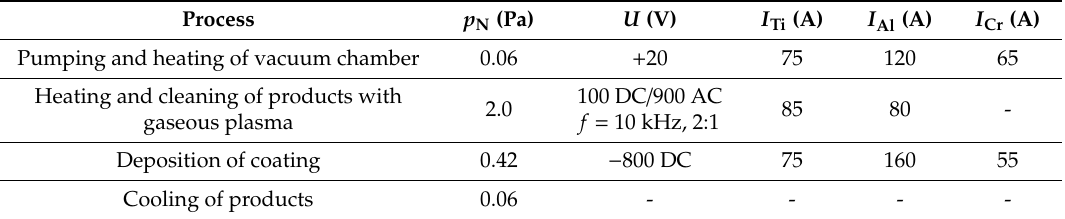
Table 1. Parameters of stages of the technological coating deposition process.